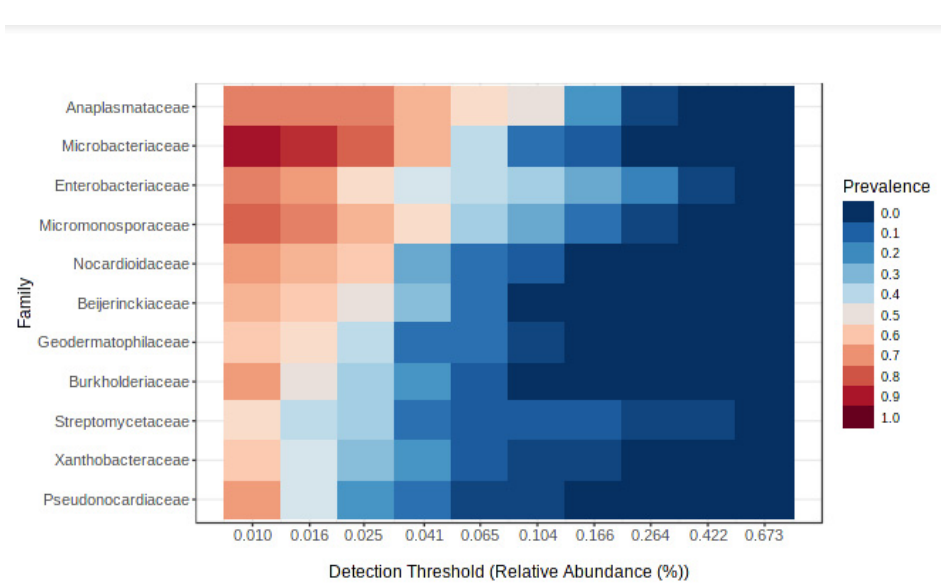
Figure 3. Heatmap showing the eleven common bacterial families present in Porcellio dilatatus gut samples. Color shading indicates the prevalence of each bacterial family among samples for each abundance threshold.